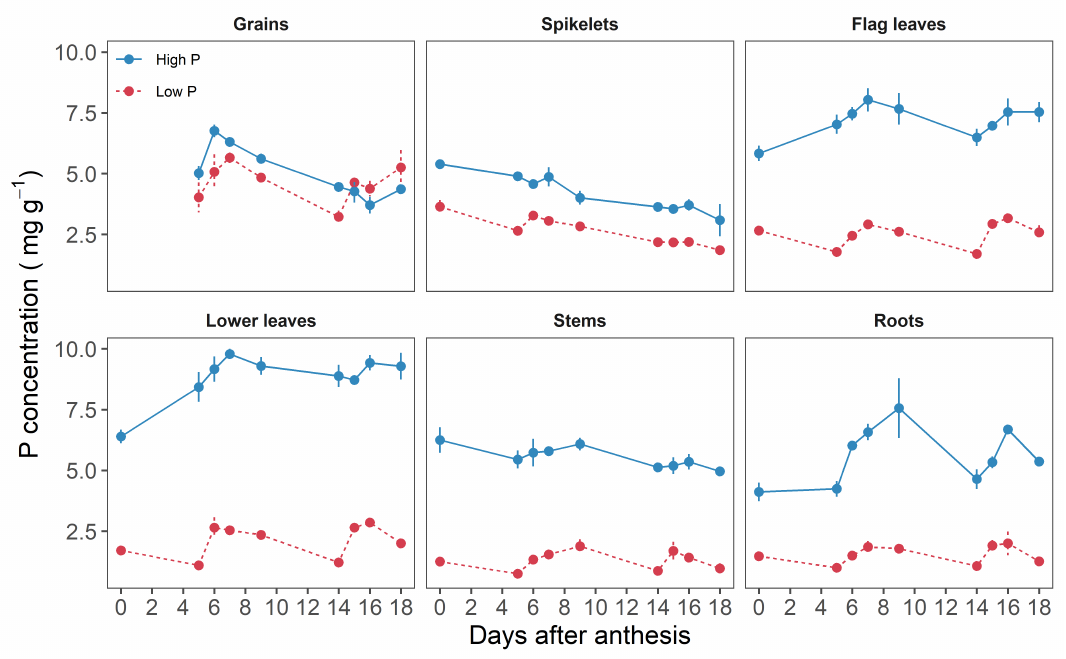
Figure 2. Phosphorus concentrations in durum wheat organs (Grains, spikelets, flag leaves, lower leaves, stems, and roots) during grain development (between anthesis and 18 days after anthesis). Plants were grown in a hydroponic culture with high or low P supply. Symbols are means of three replicates. Bars are standard